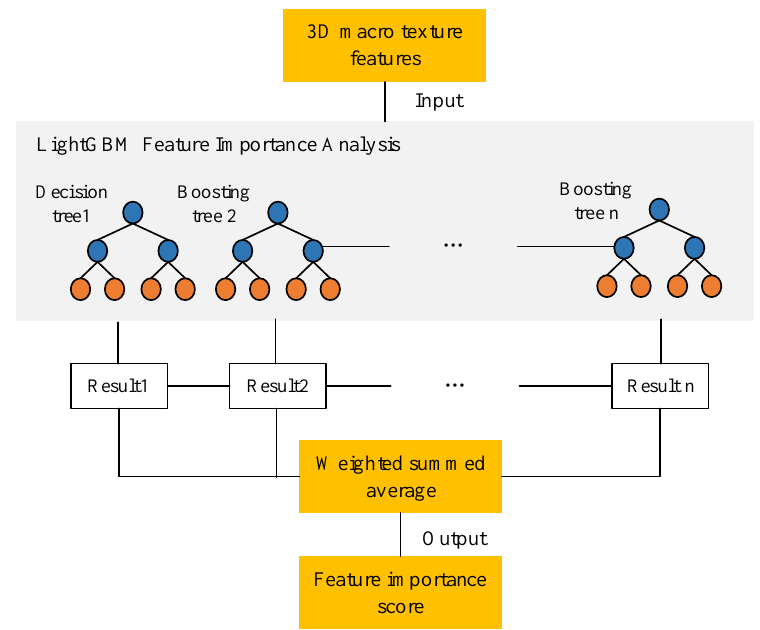
Figure 10. The analysis process of feature importance based on LightGBM.